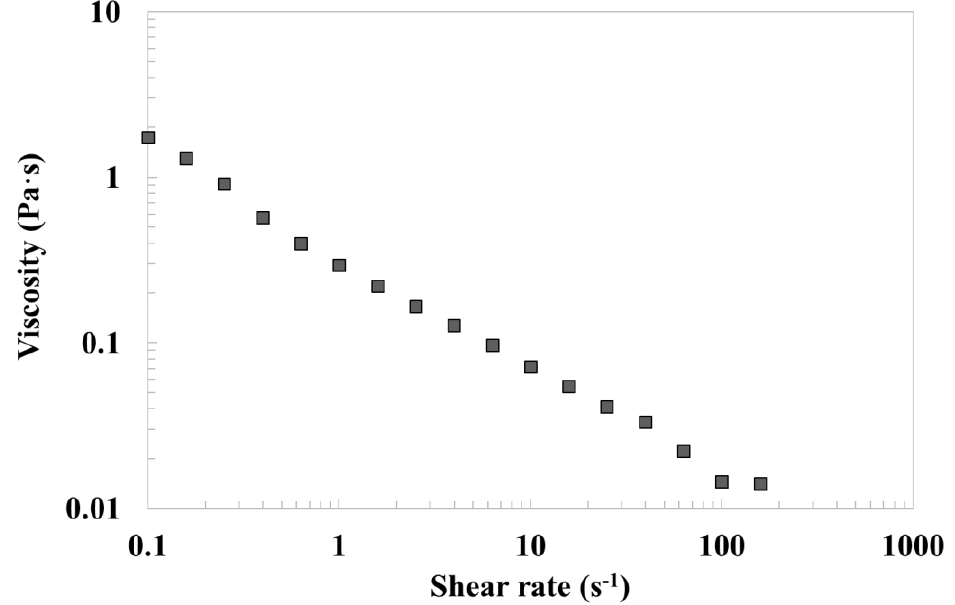
Figure 4. Flow curve of the sample with 2% w / w of hemp protein and 0.05% of gellan gum (H_2_G) at 25 °C.